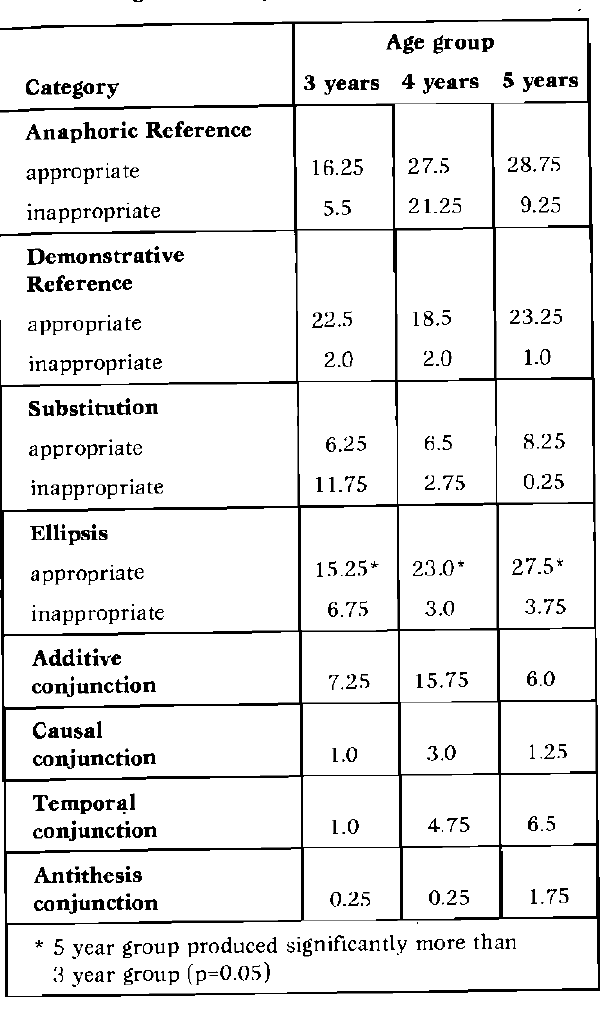
Table 4: Mean frequency scores per age group for the categories of linguistic